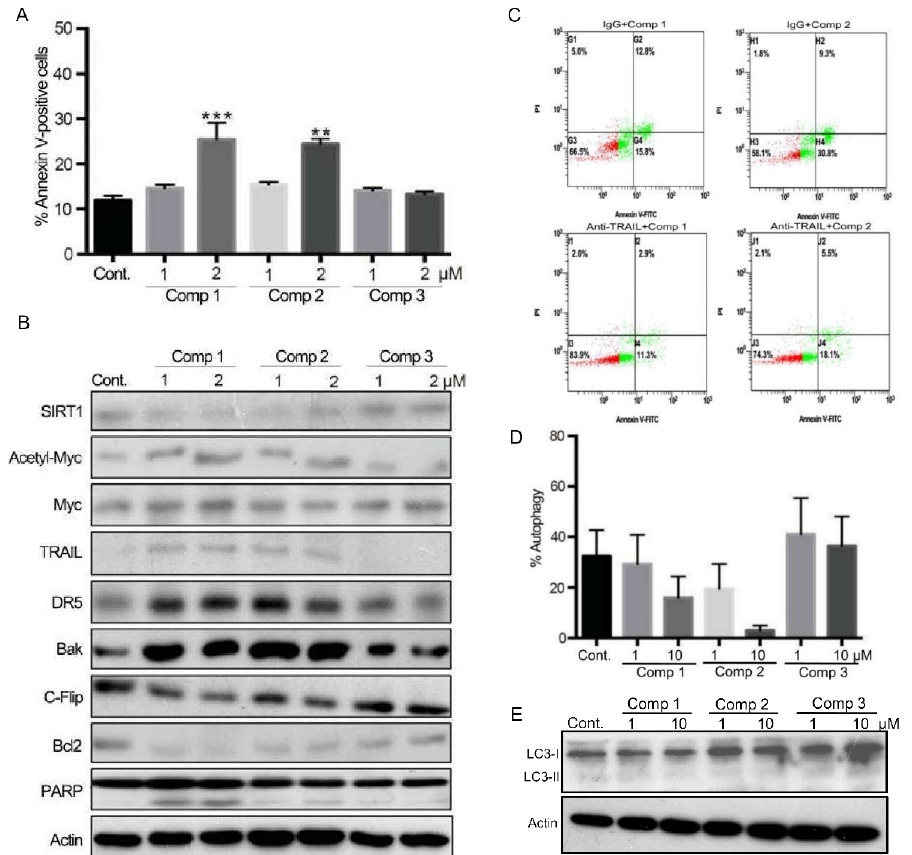
Figure 5. The effects of derivatives on protein expression and cell death in Hep3B cells. ( A ) Cells were treated with different derivatives for 24 h, and the percentage of apoptotic cells was determined by flow cytometry. H 2 O 2 treatment was used as a positive control. The presented values (mean ± SEs) represent as the percentage of cells in early and late apoptotic populations at least three independent experiments (** p < 0.01, *** p < 0.001 for treated cells vs. controls). Representative images are shown. ( B ) Hep3B cells were treated with different concentrations of compounds or vehicle for 24 h, and cell lysates were separated by SDS-PAGE and analyzed by western blotting. β -Actin was used as an internal control. Representative images are shown. ( C ) Cells were pre-treated with IgG or TRAIL- neutralizing antibody at final concentration of 1 μ L/mL for one h before exposed to different derivatives for 24 h. The percentage of apoptotic cells was determined by flow cytometry as described in A . ( D ) Cells were treated with different compounds or vehicle for 6 h. Autophagy was then determined by AO staining using flow cytometry, and the results are expressed as a percentage relative to the control group. Values (mean ± SEs) were obtained from three independent experiments. ( E ) Hep3B cells were treated with different concentrations of compounds or vehicle for 24 h, and cell lysates were separated by SDS-PAGE and analyzed by western blotting. β -Actin was used as an internal control. Representative images are